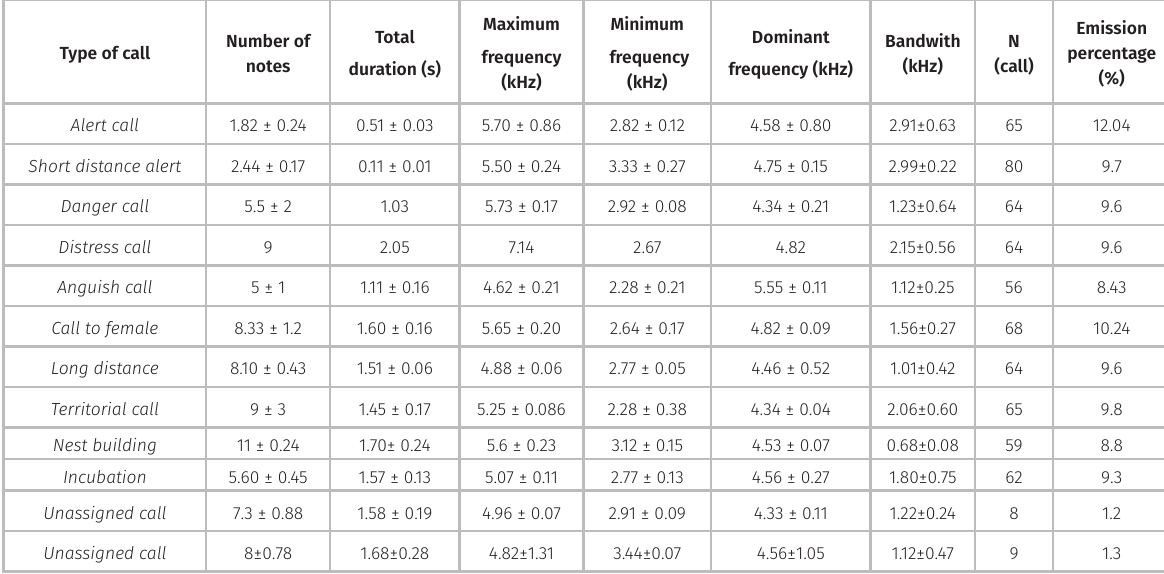
Table I. Characteristics of 12 call types of Polioptila dumicola males. Values are expressed as mean ± SD.